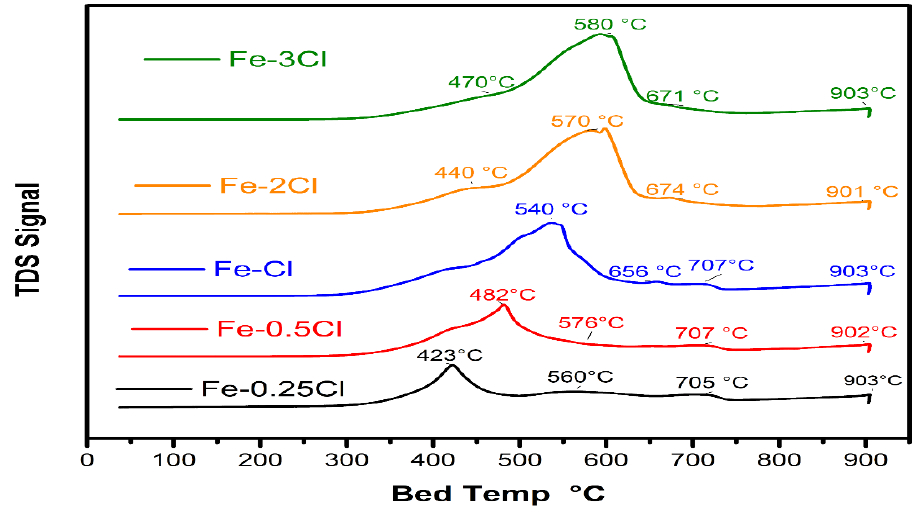
Figure 5. Temperature-programmed profiles for Fe–0.25Cl, Fe–0.5Cl, Fe–1.0Cl, Fe–2.0Cl and Fe–3.0Cl oxide catalyst.